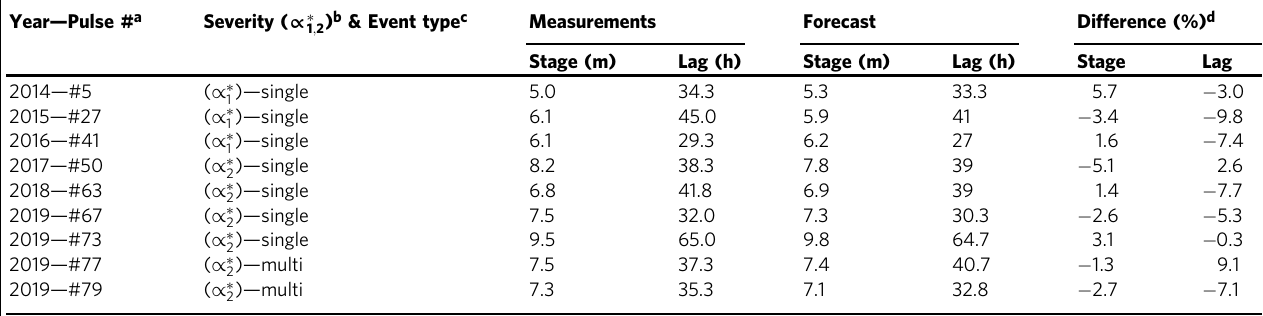
Table 4 Comparison between actual measurements and hindcasted values for selected storm pulses during the observation period at the USGS station